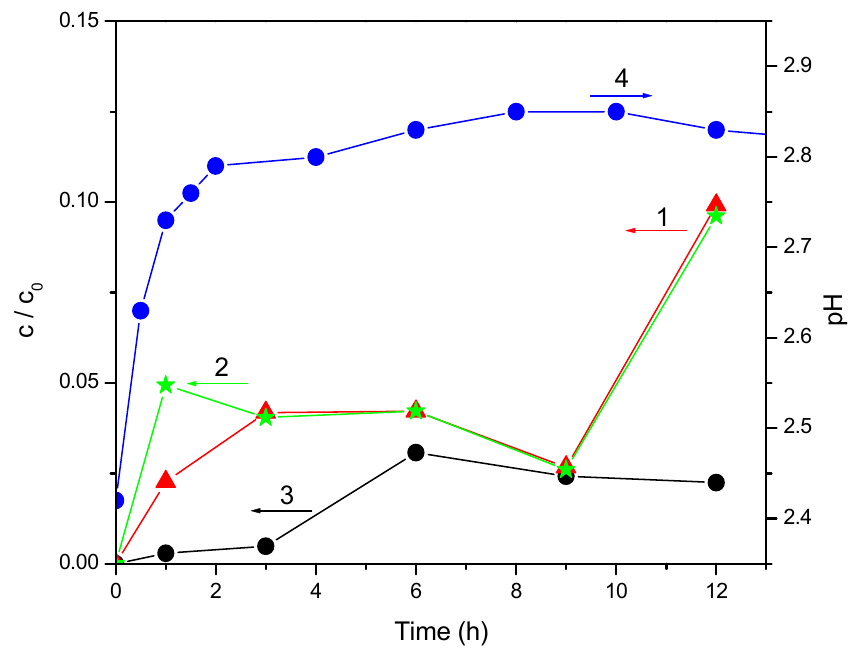
Figure 8. Photocatalytic degradation of mecoprop (2.7 mmol/dm 3 ) in the presence of N- doped TiO (1 mg/cm 3 ): (1) chloride ion formation; (2) acetate ion formation; (3) formiate 2 ion formation and (4)